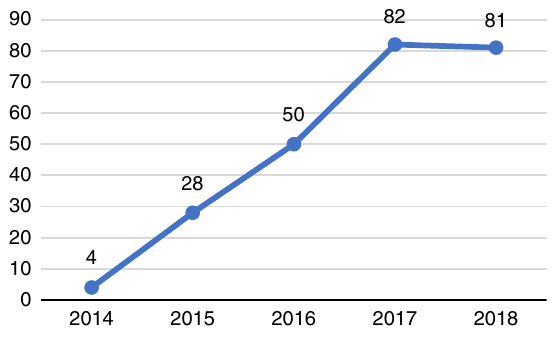
Figure 2. The distribution of the citation frequency of 31 articles in the field of e-learning recommender